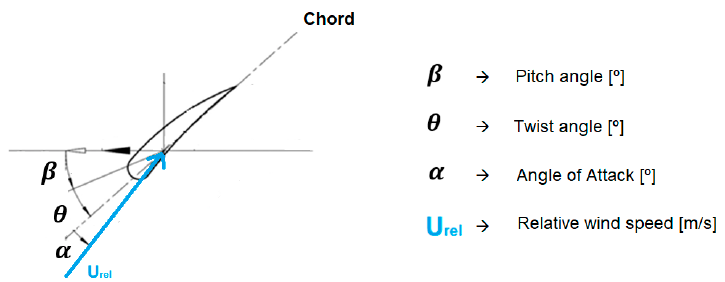
Figure 1. Definition of the pitch angle of a wind turbine blade.